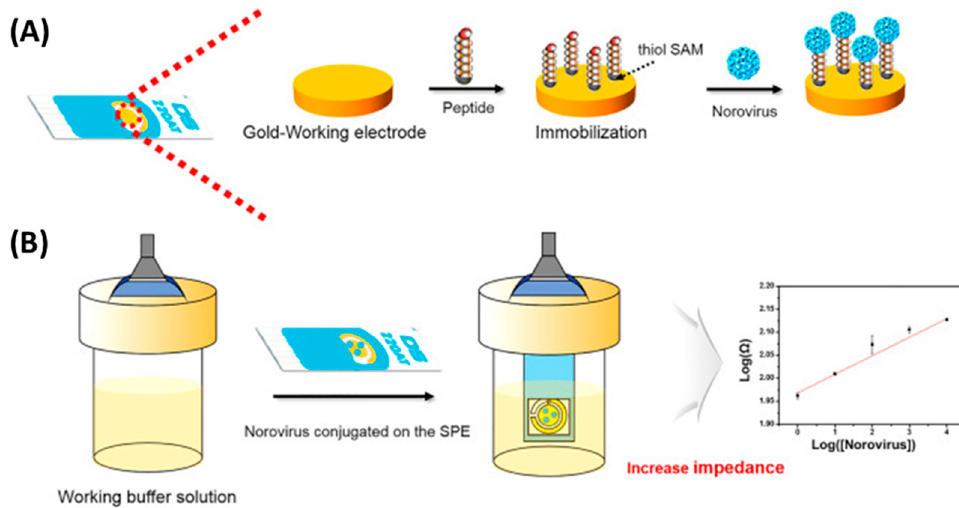
Figure 7. Schematic setup for norovirus detection using a peptide-based EIS biosensor. ( A ) The novel peptides were immobilized by the formation of SAMs on the Au working electrode. ( B ) Using a working buffer solution, the dropped norovirus on the Au working electrode was then measured, along with its strength affinity, by using an EIS analysis [40]. Copyright 2019, Elsevier.